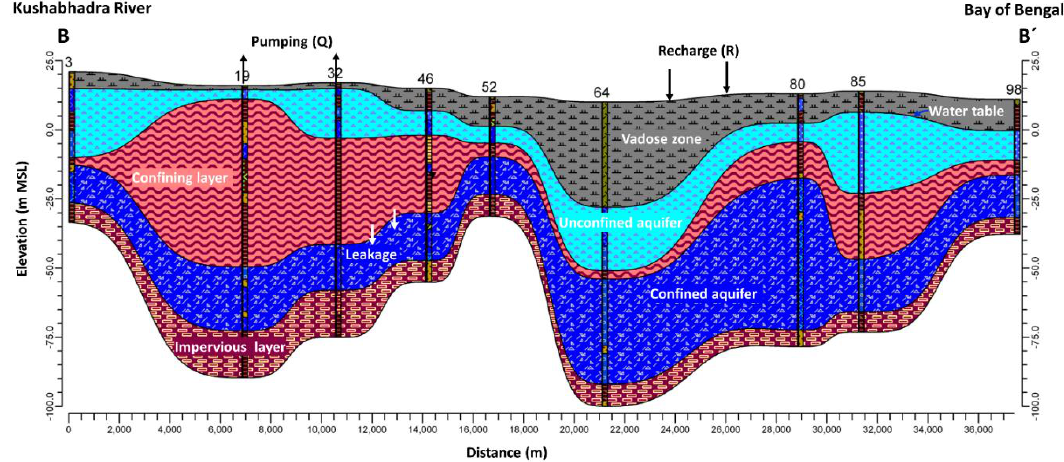
Figure 2. Conceptual model of the study area at B-B’ cross-section (adapted from [62]).